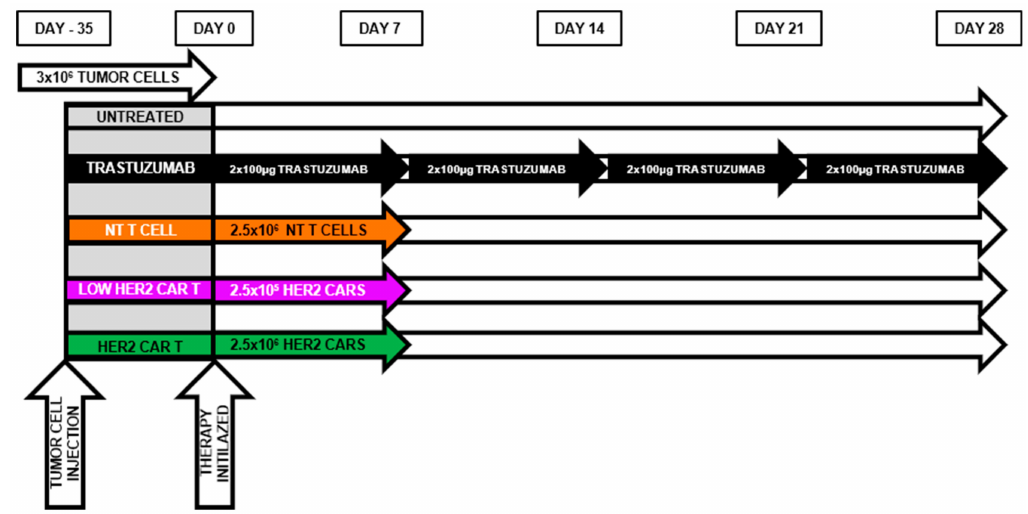
Figure 4. Outline of in vivo animal treatment schedule: Mice were s.c. injected with 3 × 10 6 JIMT-1 cells. 35 days later (on day 0), mice received 100 µ L PBS bu ff er twice weekly (untreated, n = 5), 100 µ g trastuzumab in 100 µ L PBS bu ff er twice weekly (trastuzumab, n = 5), or an i.v. dose of 2.5 × 10 5 HER2 CAR mouse T cells (low-dose HER2 CAR, n = 5), or an i.v. dose of 2.5 × 10 6 HER2 CAR mouse T cells (HER2 CAR, n = 5). Tumor growth was followed by caliper and was derived as the product of the length, width and